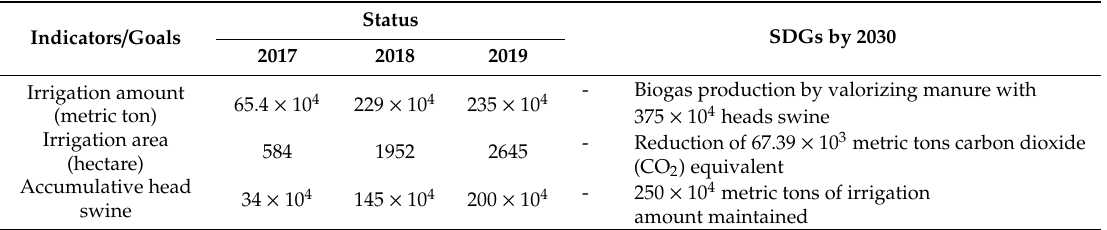
Table 2. Status of swine manure recycling and its sustainable development goals (SDGs) in Taiwan.